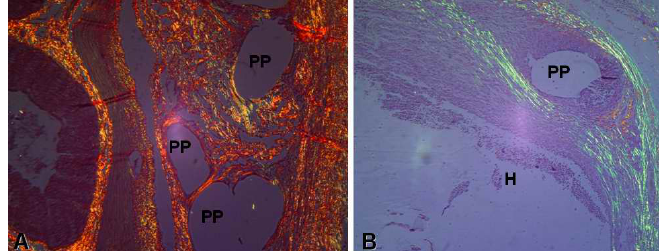
FIGURE 5 - Photomicrographies in polarized light of a group PP sample ( A ) and of group PH ( B ), 30 days after the implantation (picrosrius, 100x). Evidencing the predominance of type I colagen (mature) with red coloration and type III colagen (imature), with green coloration. Whereas: PP Site taken by polypropylene monofilament; H Site taken by